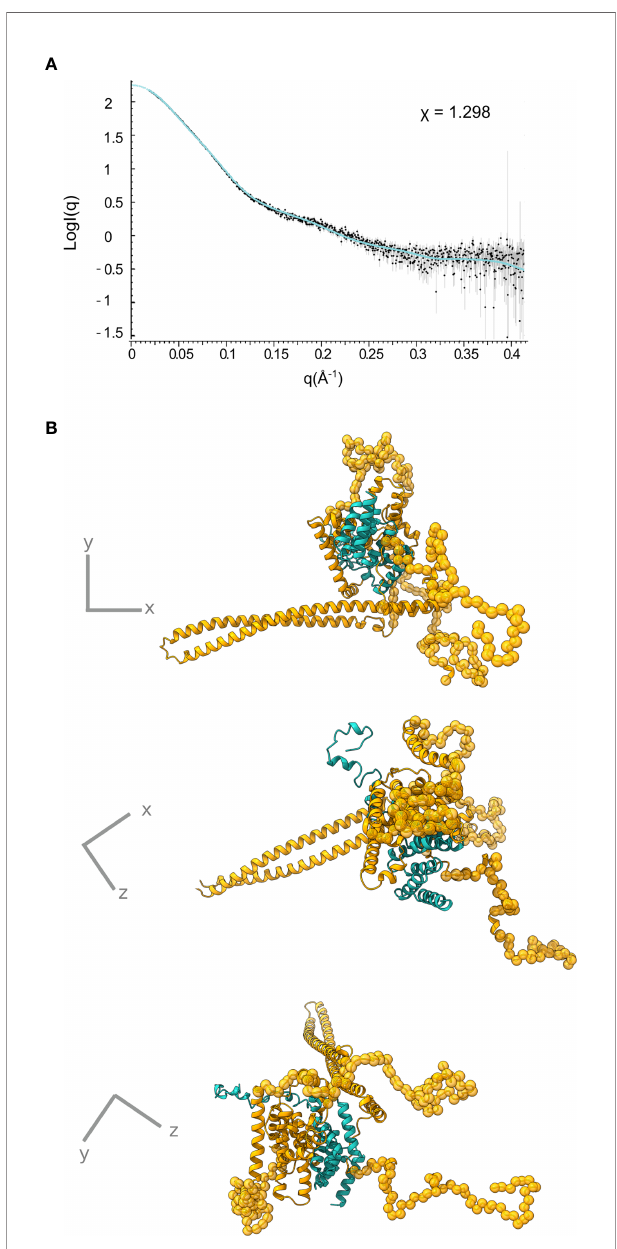
FIGURE 5 | IpgC/IpaB SAXS model. (A) Fit of the theoretical SAXS pattern calculated from the model in (B) to the experimental SAXS data. (B) Three perpendicular representations of the IpgC/IpaB SAXS model. IpaB is depicted in yellow-gold and IpgC in turquoise. Residues where high resolution information is available (crystal structure or homology model) are shown in cartoon representation while spheres represent dummy